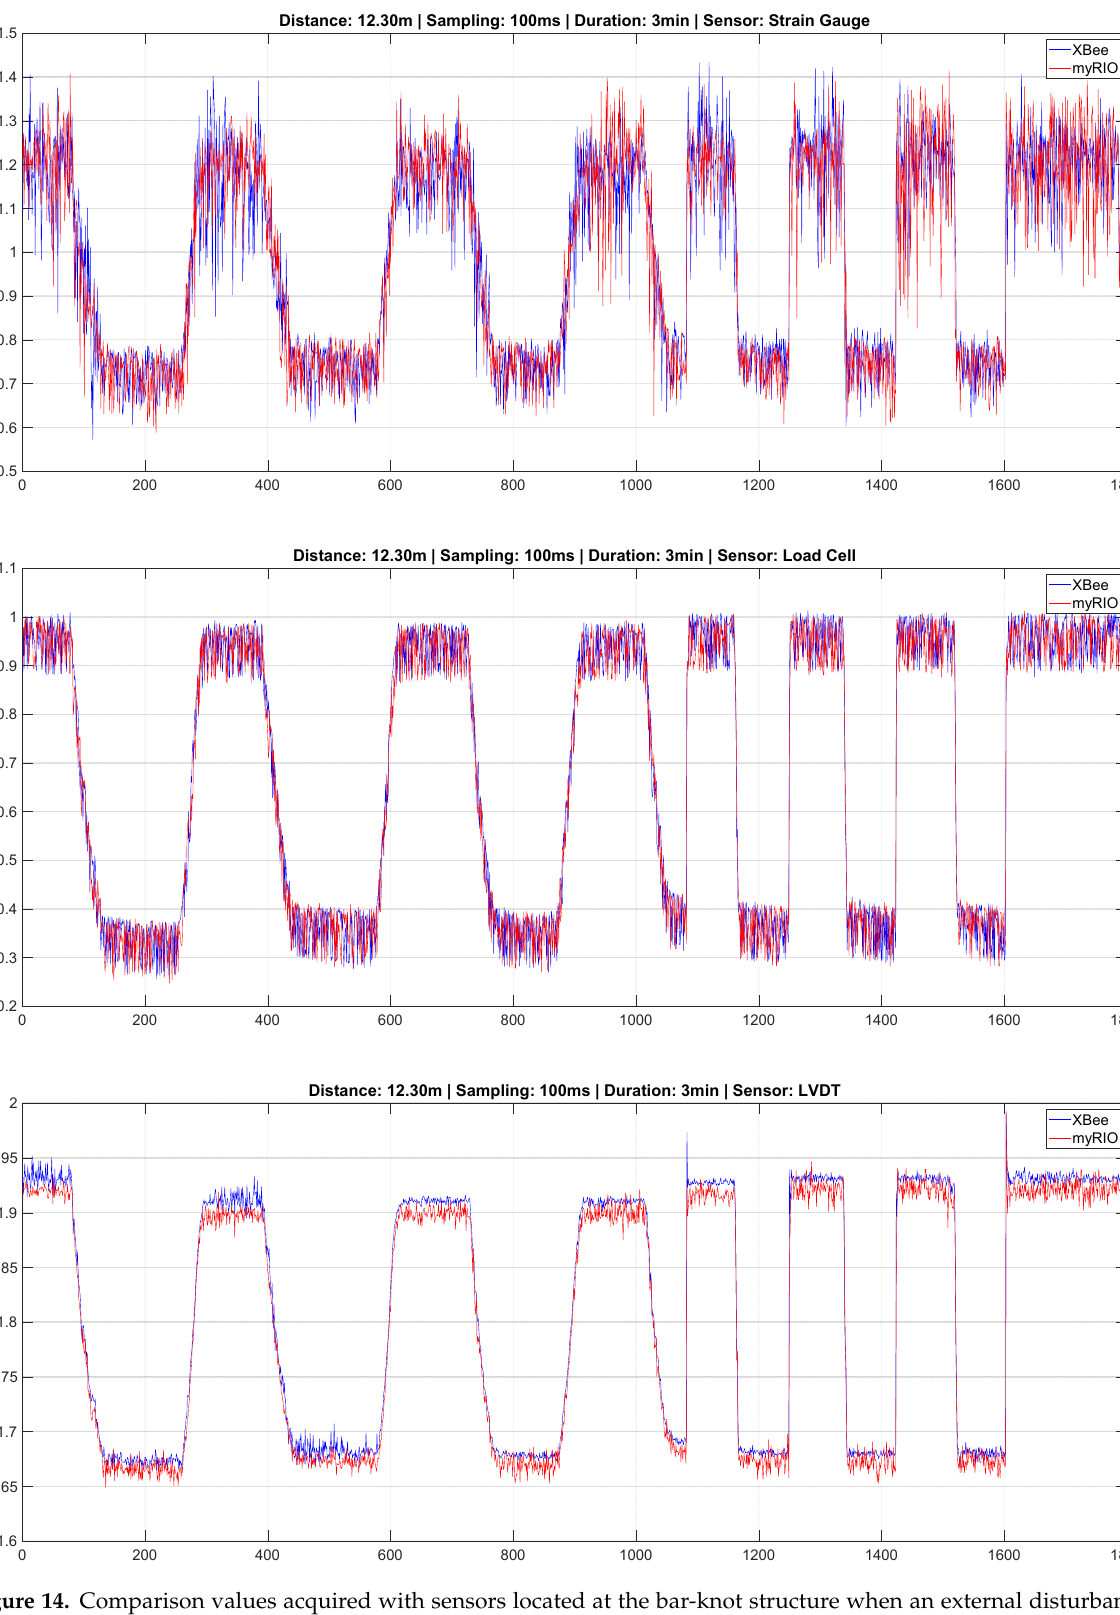
Figure 14. Comparison values acquired with sensors located at the bar-knot structure when an external disturbance is applied. Frequency: 10 Hz; Measuring/acquisition separation: 12.30 m. Test duration 3 min. Strain-gauge (top); LVDT (medium) and Load-cell (bottom). Wireless values shown in blue and wired values in red.